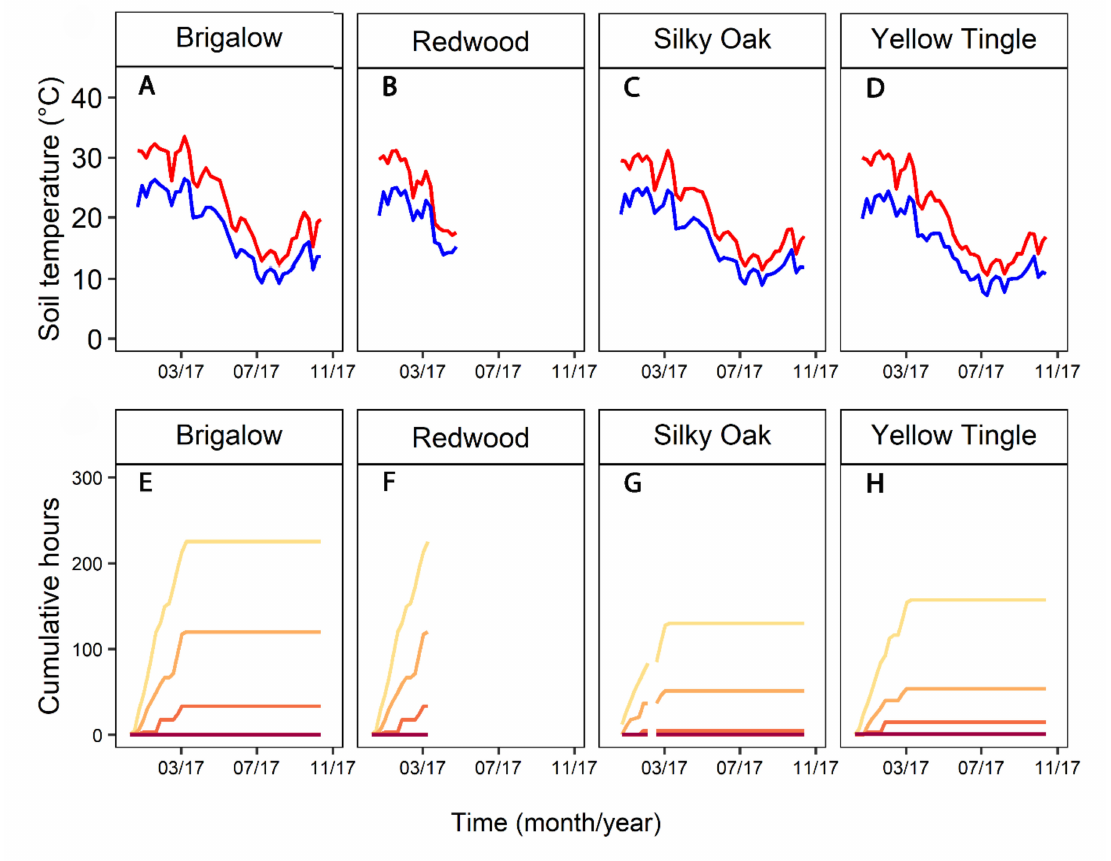
Figure 8. Soil temperatures at 30 cm depth of ( A ) Yellow Tingle bund ( B ) Silky Oak bund ( C ) Brigalow bund and ( D ) Redwood bund, and the cumulative number of hours of soil temperatures > 32 ◦ C at ( E ) Yellow Tingle bund ( F ) Silky Oak bund ( G ) Brigalow bund and ( H ) Redwood bund. The shaded, small (1.4 m high) Redwood bund had the greatest recovery of P. cinnamomi at